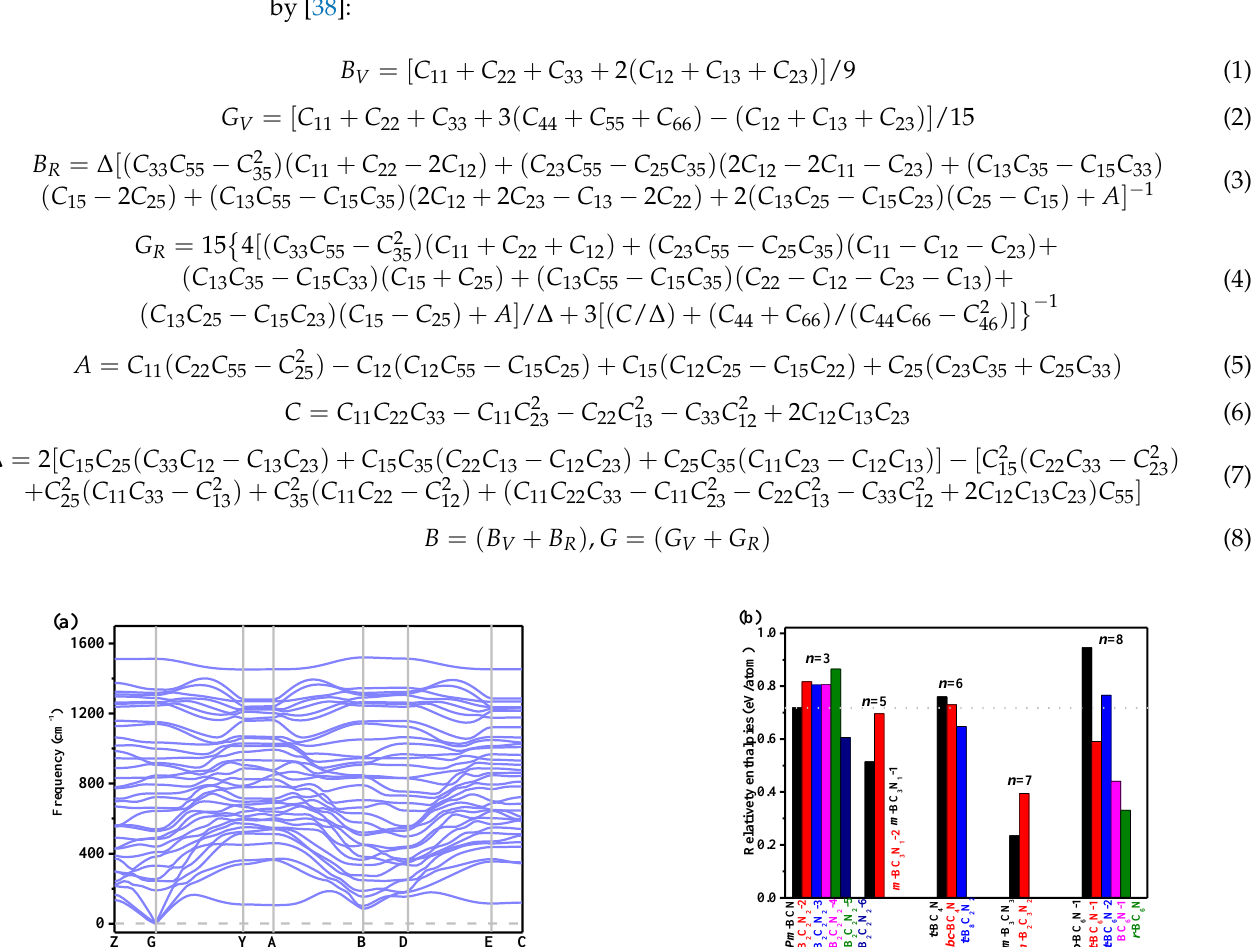
Figure 3. Three-dimensional structure of G max ( a ), G min ( b ), Poisson’s ratio v max ( c ), v min ( d ), and E ( e ) of Pm -BCN.